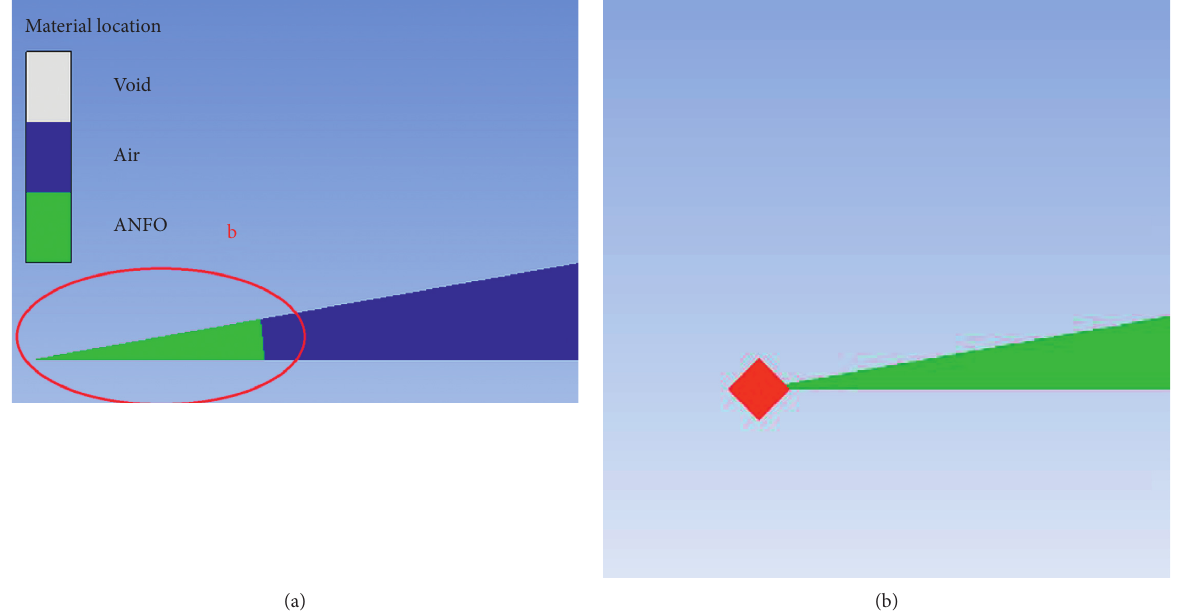
Figure 6: Explosive details (homemade ANFO charge in the example): (a) “zone a” (from Figure 5) and (b) detonation point (detail “zone b” from Figure